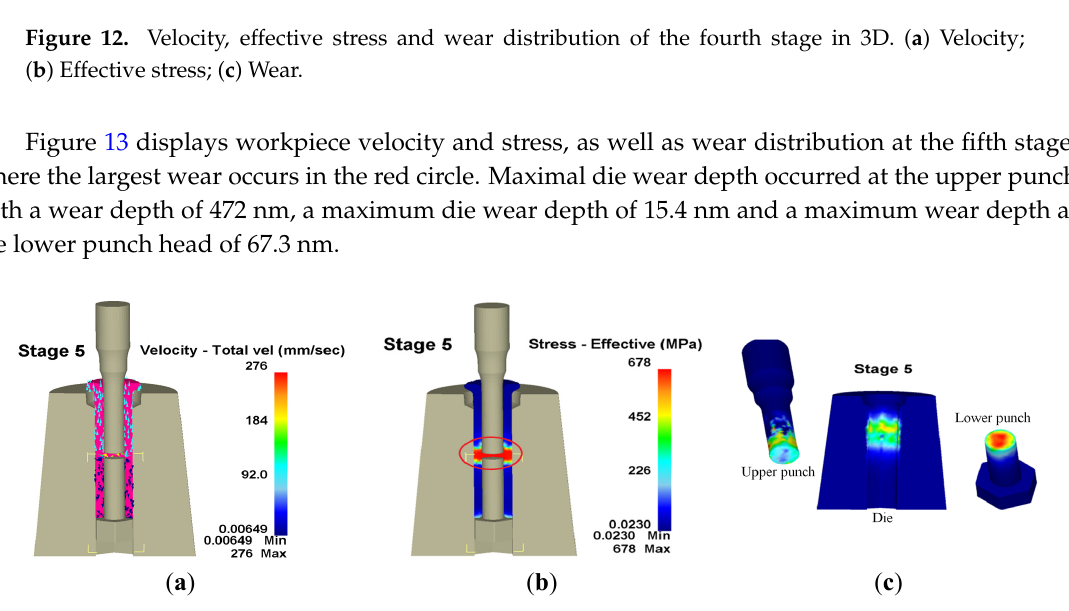
Figure 12. Velocity, effective stress and wear distribution of the fourth stage in 3D. ( a ) Velocity; ( b ) Effective stress; ( c ) Wear.